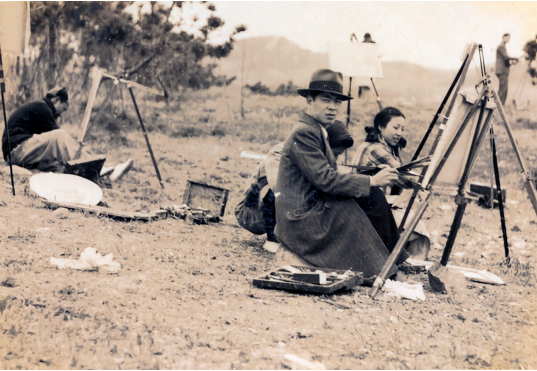
Figure 1. Archival photograph of Liu Kang during outdoor painting class with students in Shanghai, in 1933. Liu Kang family collection. Images courtesy of Liu family.